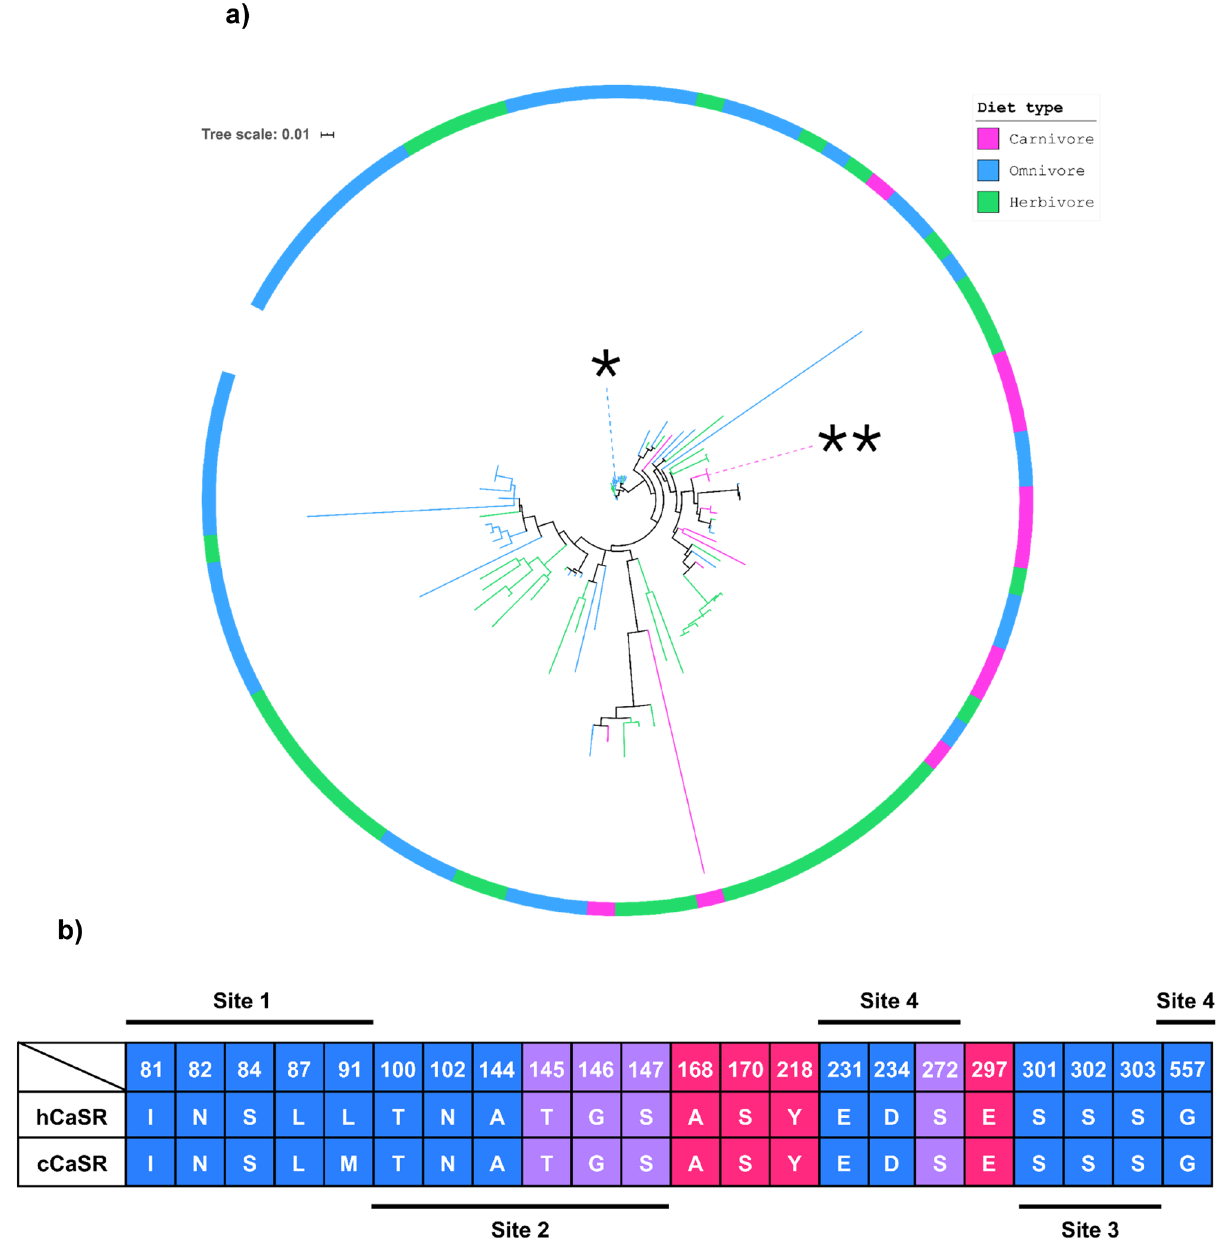
Figure 2. CaSR phylogenetic tree of mammalian species ( a ) and alignment of the residues from all four Ca 2+ binding sites compared between cCaSR and hCaSR ( b ). ( a ) Labels are coloured by diet type (green = herbivore; blue = omnivore; pink = carnivore). *— Homo sapiens, **—Felis catus . ( b ) Sequence alignment comparing the residues that bind Ca 2+ (blue), GSH (red) or both (purple) for hCaSR and cCaSR. The sites indicated, correspond to Ca 2+ binding sites on the receptor 20